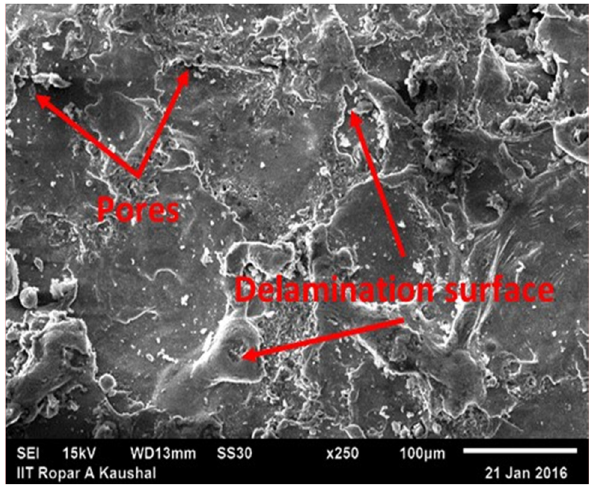
Figure 6: SEM image of Al/15 wt%SiC/5 wt%Gr – MMC hybrid com - posite after